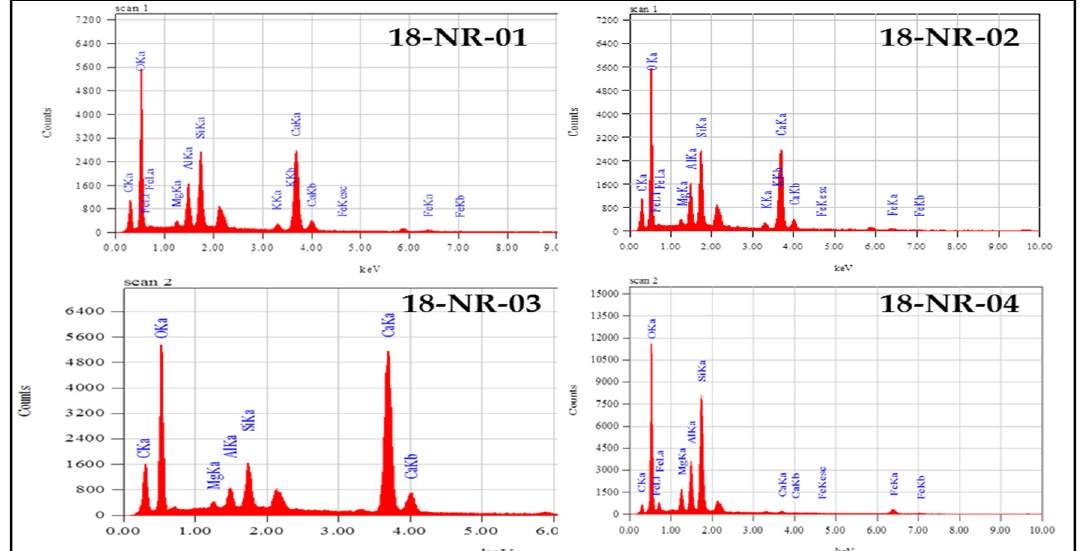
Fig. 5: SEM-EDS Pattern Data Showing the Elemental Compositions of the Samples